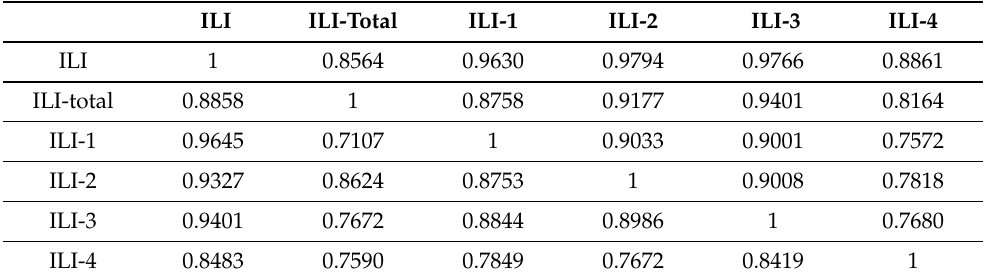
Table 5. Matrix [ µ 1 ] Max ,10,6 .